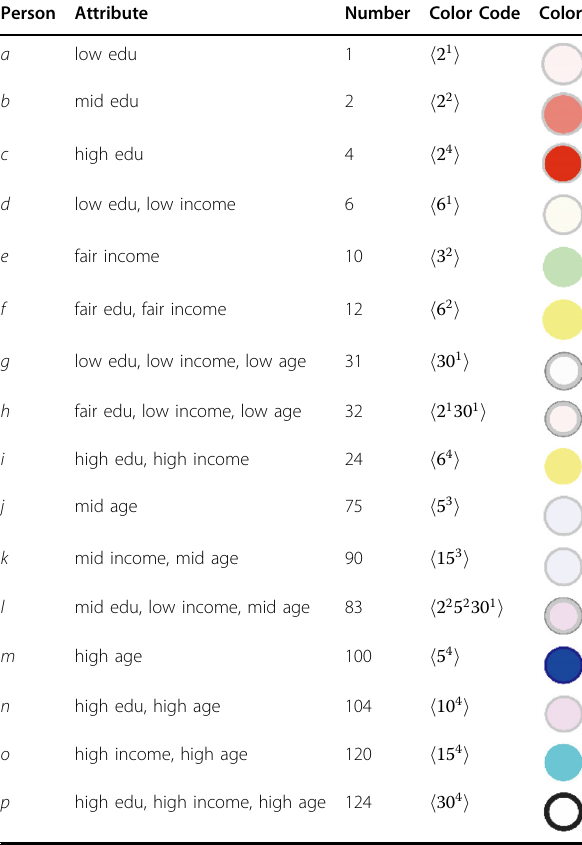
Table 4 Assigning color codes of individual people with multiple attributes Person Attribute